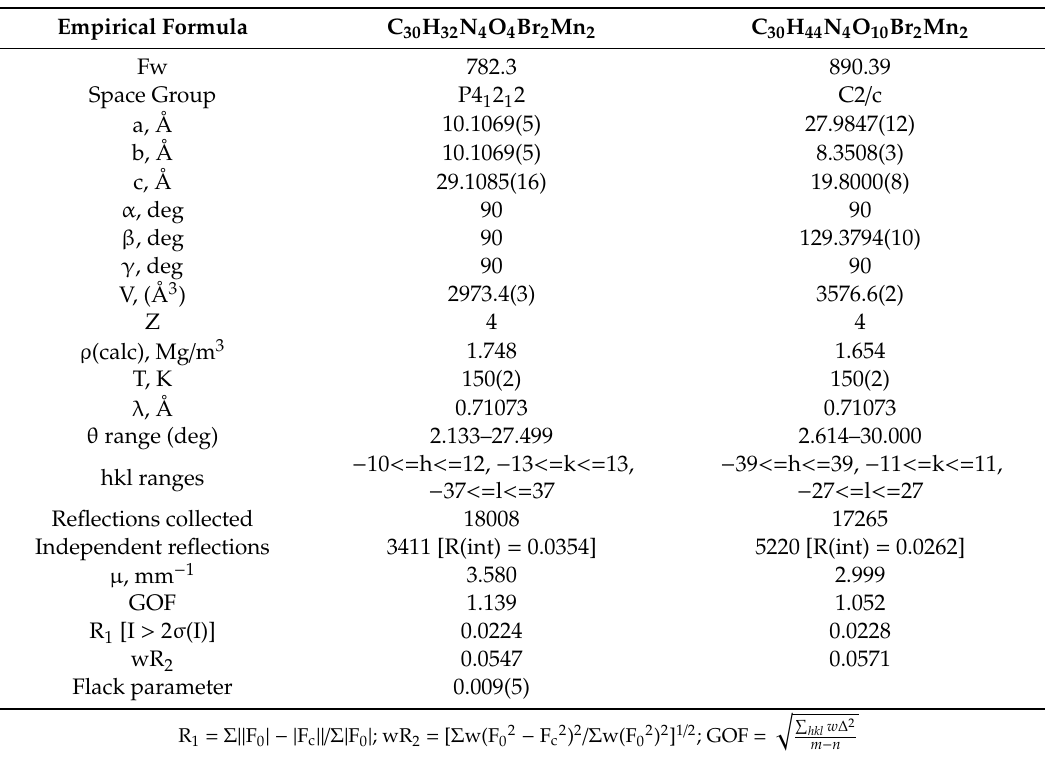
Table 1. Refined crystal data and unit cell information.